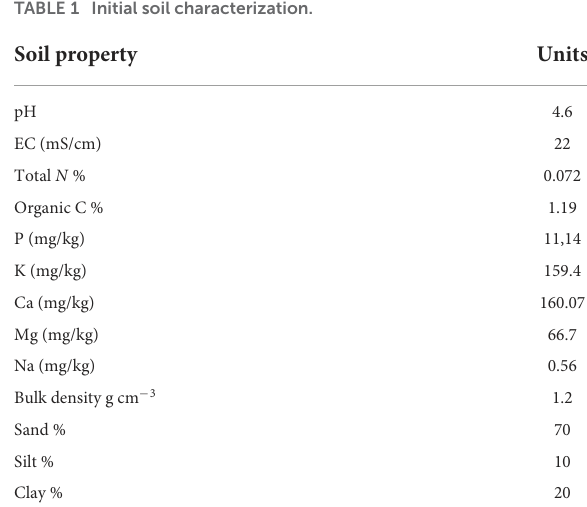
TABLE 1 Initial soil